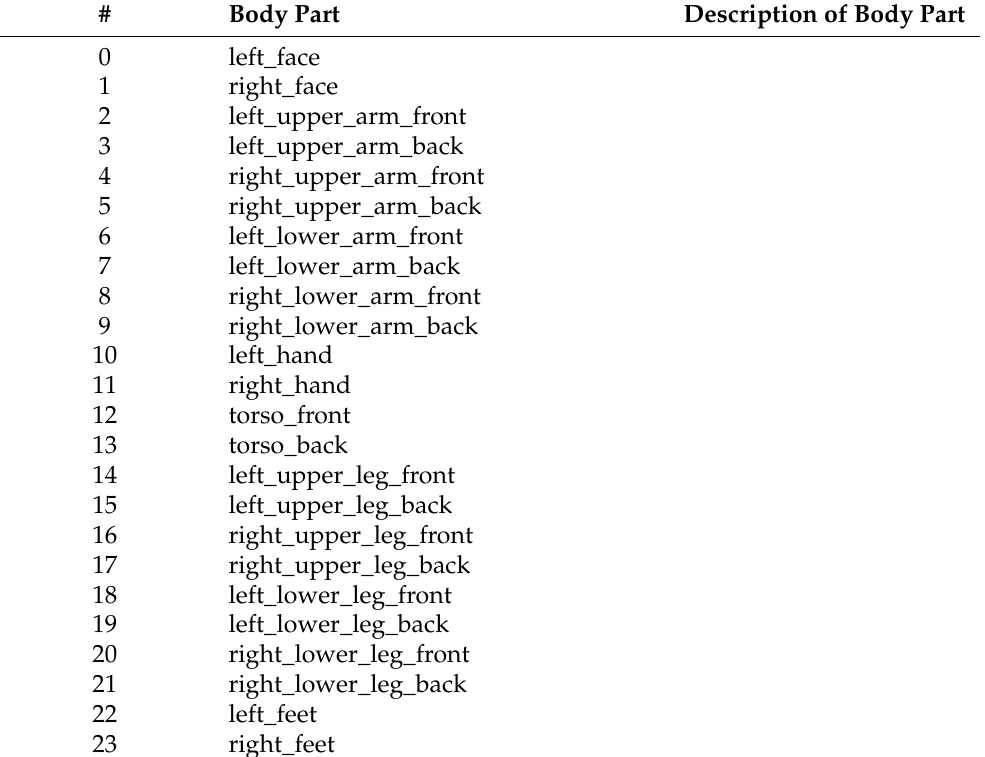
Table 1. Index table with the identifier of each body part detected by the Bodypix model. Body Part Description of Body Part